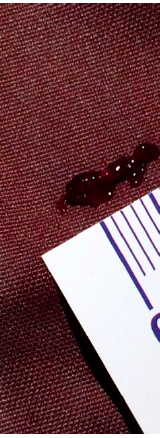
Figure 3. The aspirated thrombus .